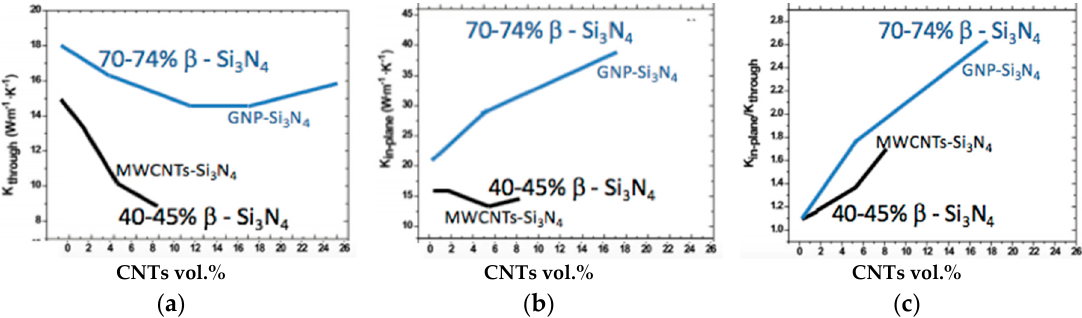
Figure 14. Thermal conductivity of CNT- and graphene nanoplatelets (GNP)-reinforced Si 3 N 4 : ( a ) through-thickness; ( b ) in-plane; and K in-plane / K through-thickness ratio, ( c ) silion nitride composites with MWCNTs and GNP as a function of carbon nanostructures, based on [94].